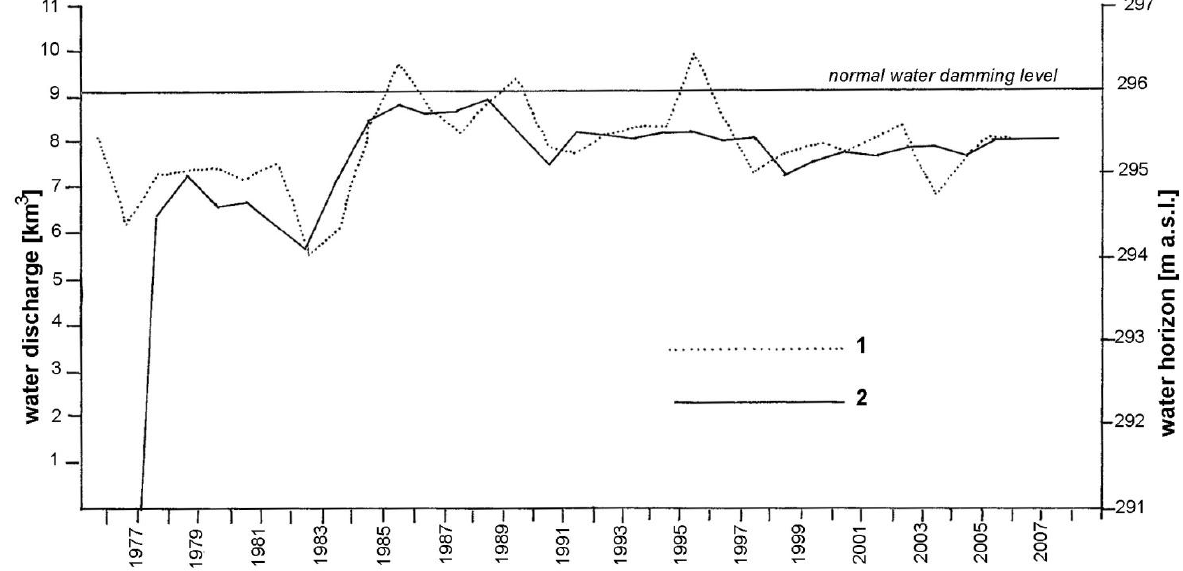
Fig. 4. The average annual water discharge (1) of the Ust-Ilim power plant and the average water horizon (2) of the Ust- Ilim reservoir (Data of Irkutskgidromet; after Tashlykova, 2010,